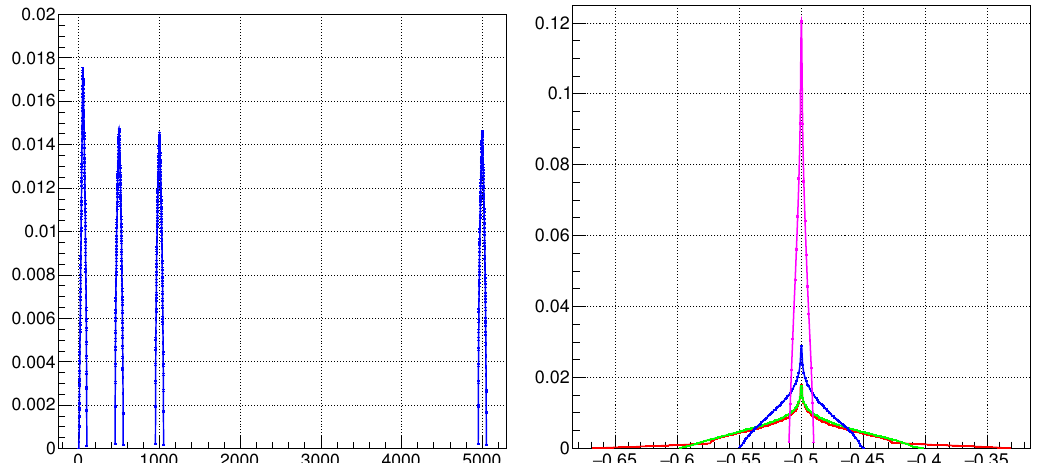
Figure 5 . The transverse momentum (left) and the rapidity (right) of the vector boson after initial state radiating for a (cid:12)xed jet momentum with transverse momentum p rapidity of 0 : 4 and born rapidity of the vector boson equal to (cid:0) 0 : 5. chooses to add the unclustered partonic radiation back to the vector boson momentum one would recover fully the initiating Born